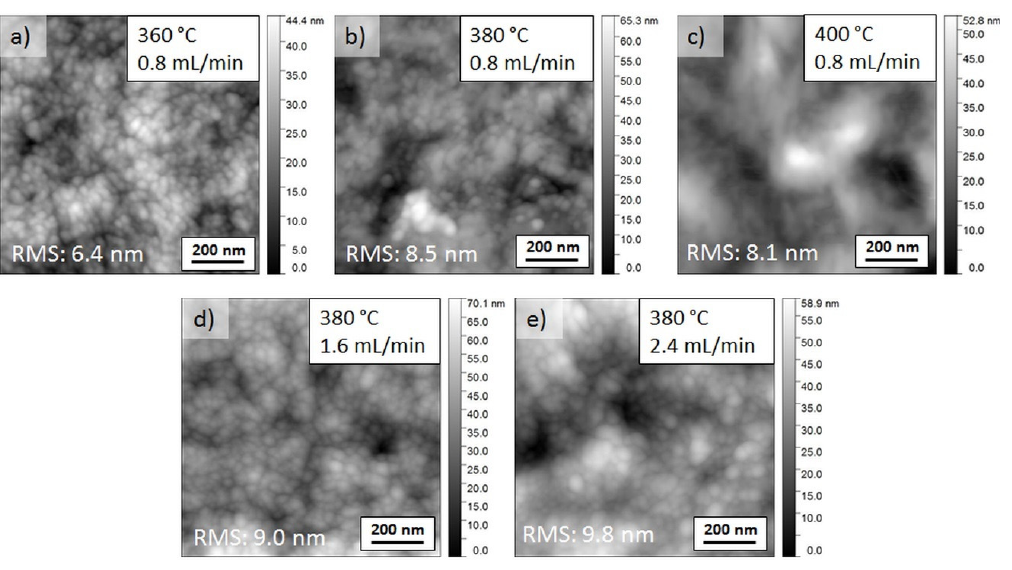
Figure 3. AFM images of ( a ) IZO-1; ( b ) IZO-2; ( c ) IZO-3; ( d ) IZO-2; ( e ) IZO-4; and ( f ) IZO-5.